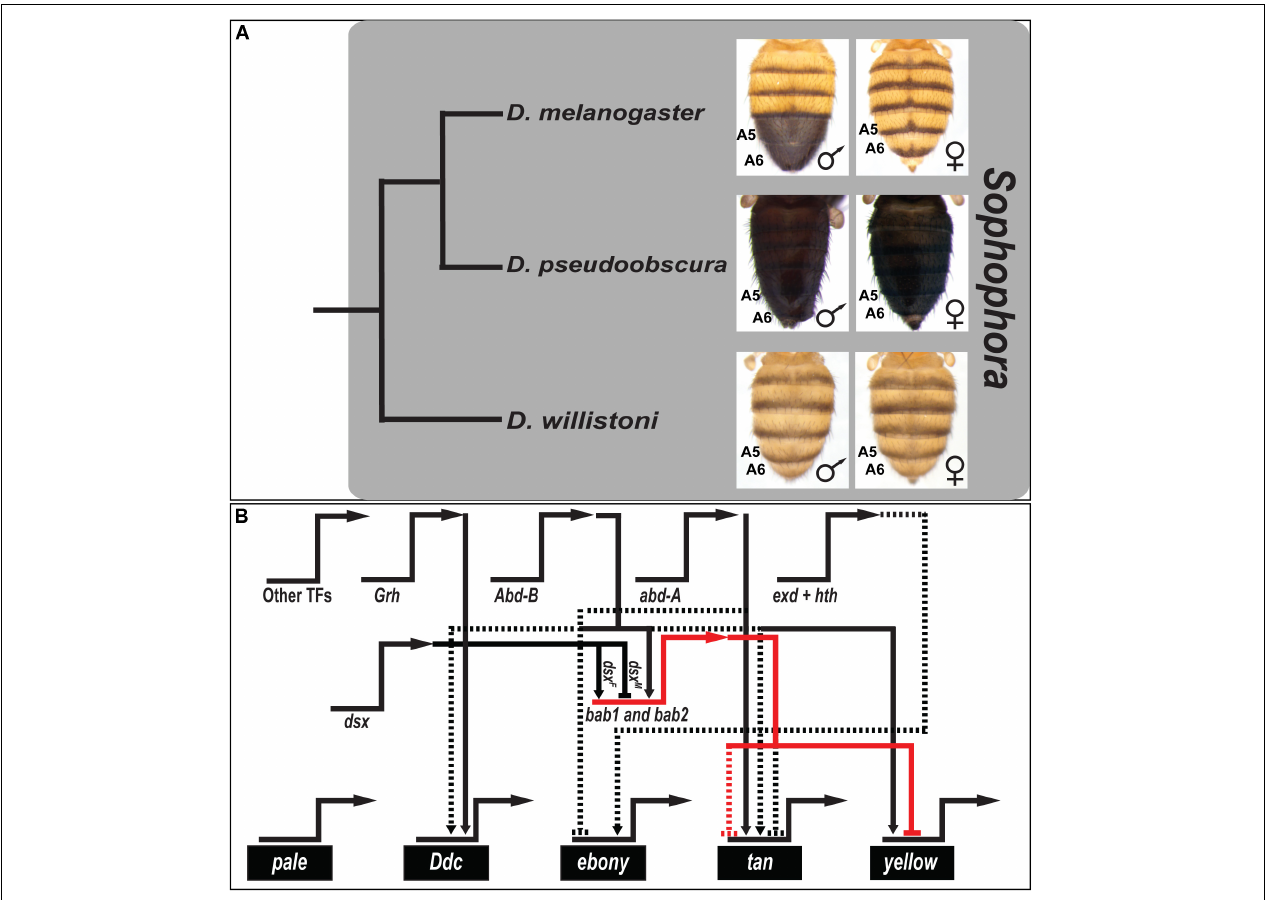
FIGURE 1 | The canonical model for the origin of sexually dimorphic abdomen pigmentation of D. melanogaster , and its underlying gene regulatory network. (A) Phylogenetic relationship of model species of the Sophophora subgenus. Here, monomorphism is presumed to be ancestral, and dimorphism derived. (B) The current understanding of the gene regulatory network for the D. melanogaster phenotype has key transcription factor genes (regulatory genes) driving the expression of genes that encode proteins that participate in a pigment metabolic pathway (differentiation genes). The horizontal-pointing arrows represent expression occurring from the named loci. Key nodes within this network drive the male-limited expression of the tan and yellow genes, whose expression in females is repressed by the activity of the bab1 and bab2 transcription factor genes. Solid connectors between genes represent known direct interactions between the encoded transcription factor and a binding site(s) in the target gene’s cis -regulatory element. Dashed lines represent regulation not confirmed as direct. Activation is indicated by connectors terminating with an arrowhead, and repression as a nail head